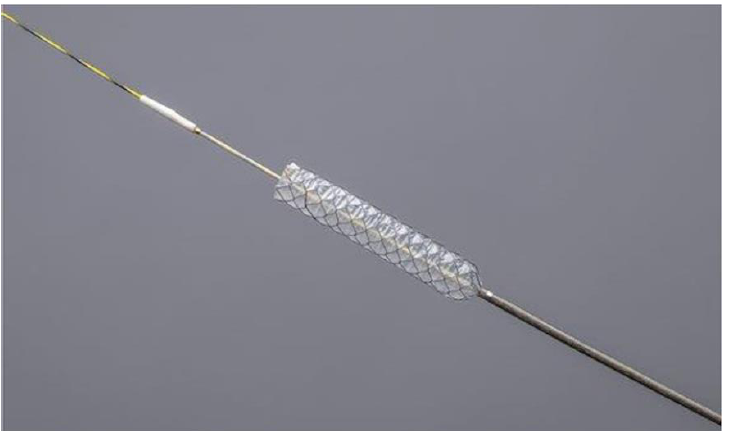
Figure 1. HANAROSTENT Benefit (Boston Scientific Japan, Tokyo, Japan). The fully covered, braided-type, self-expandable metal stent of 8 mm diameter with an ultra-slim introducer of 5.9-Fr. (image provided by Boston Scientific Japan).